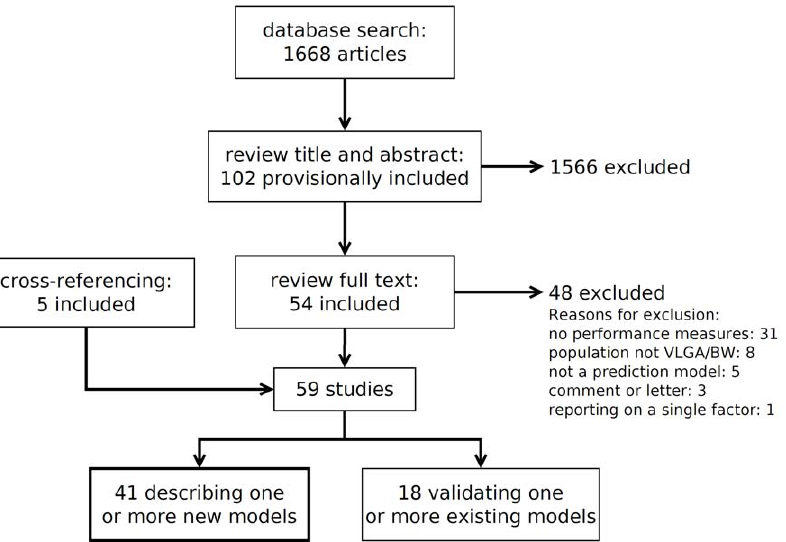
Figure 1. Results of search. This review focuses on the 41 development studies, which describe previously unpublished models predicting mortality.